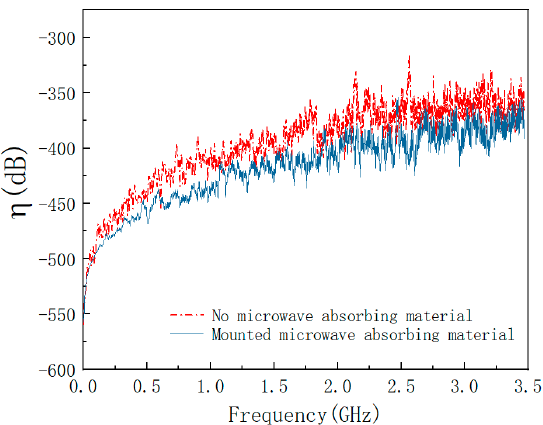
Figure 14. Coupling coefficient before and after mounting absorbing material under HEMP.